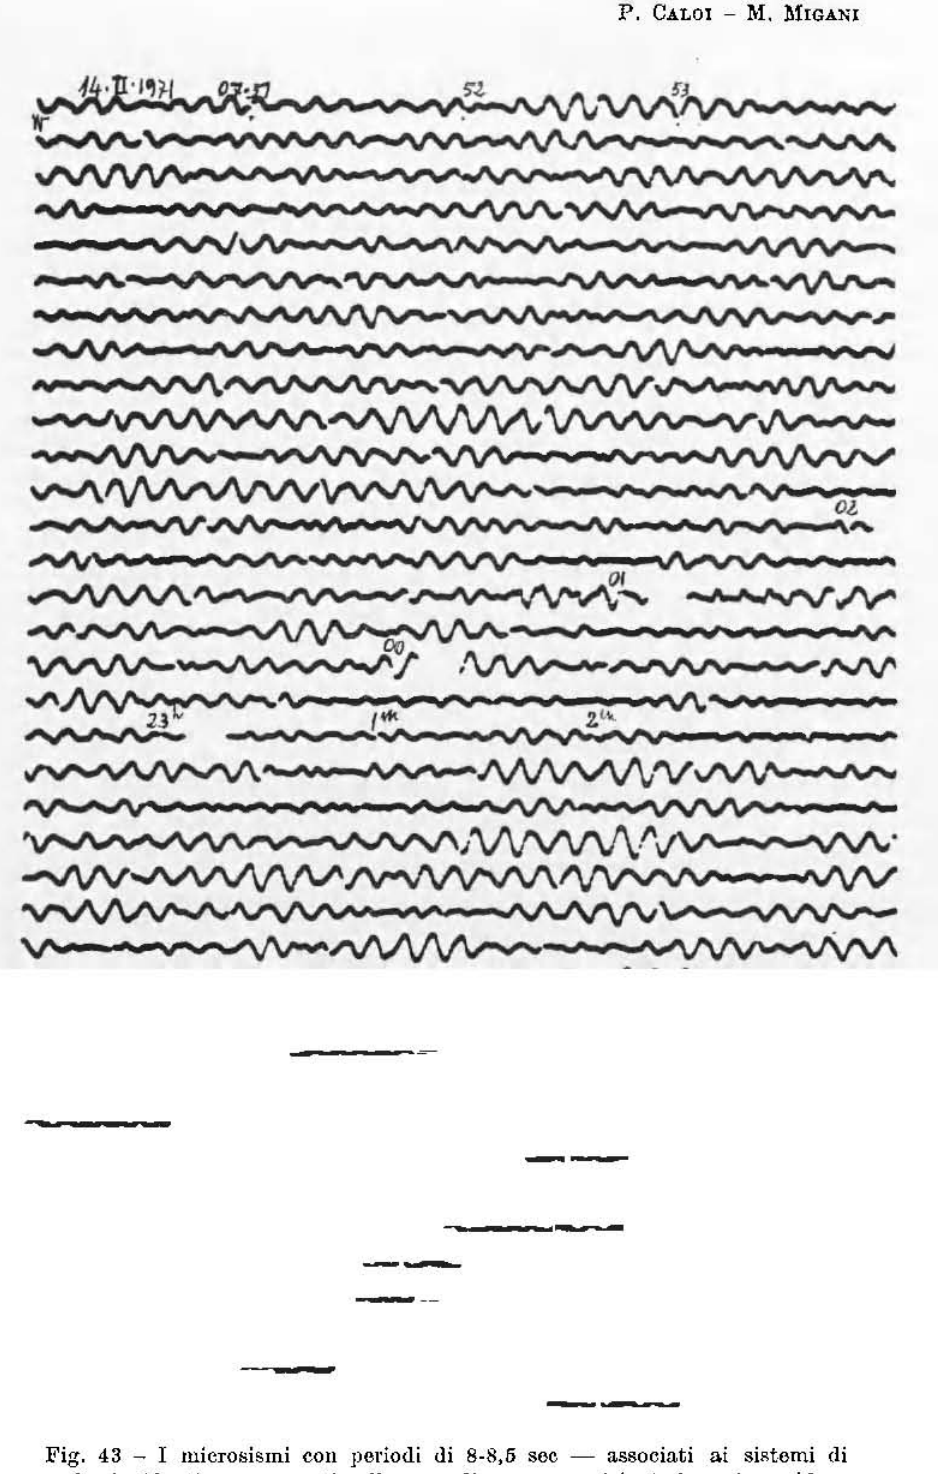
Fig. 43 - I microsismi con periodi di 8-8,5 see - associati ai siRtemi di onùe significative, }Jrovoeati nella zona di mare prospiciente le coste occiden tali dell'Irlanda dalla Ilerturbazione vasta e profonda, di cui alle figure 40- 44, si }Jl'opagano alle lllaR!\illle distanze. Quello sO}Jra ri}Jortato ò un tratto ùella registrazione ottenuta presso la Stazione Sismica di Roma (Città. Uni versitaria) da un apparecchio Galitzin-Wili}J alla dsitanza di oLtre 2.000 km. La mancanza di }Jerturbazioni secondarie, di qualChe iIllIlortanza, nel Tineno settentrionale, consente una registrazione }Jressoché indisturbata. Fig. 43 - The microseisIlls with Ilel'iods of 8-8,5 sec, associated to signi ficant wave systeltls and raised in the sea area olT the \Vest coast of Ireland by the vast and deep perturbation shown by figs. 40 anù 44, }Jl'o}Jagate to ma:ximum distances. The above is a secUon of the recording maùe in the Seismic Station of University City of Rome by a Galitzin-Wùi}J instrument at over 2000 klllS distance. Since no secondary perturbations of a certain weight were }Jl'esent in the Northern Tyrrhenian area, the recorùing was almost